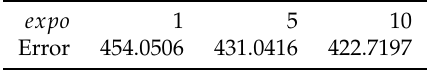
Table 5. Exponent in the random sampling and associated